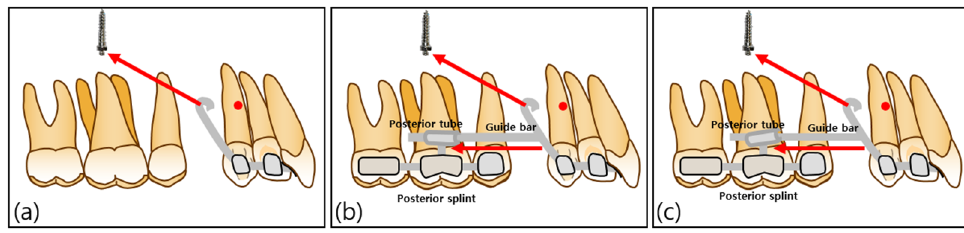
Figure 11. Schematic diagrams of the C-lingual retractor (CLR) and antero-posterior lingual retrac- tor (APLR): ( a ) CLR group; ( b ) APLR group with parallel posterior tubes; ( c ) APLR group with distally angulated posterior tube.